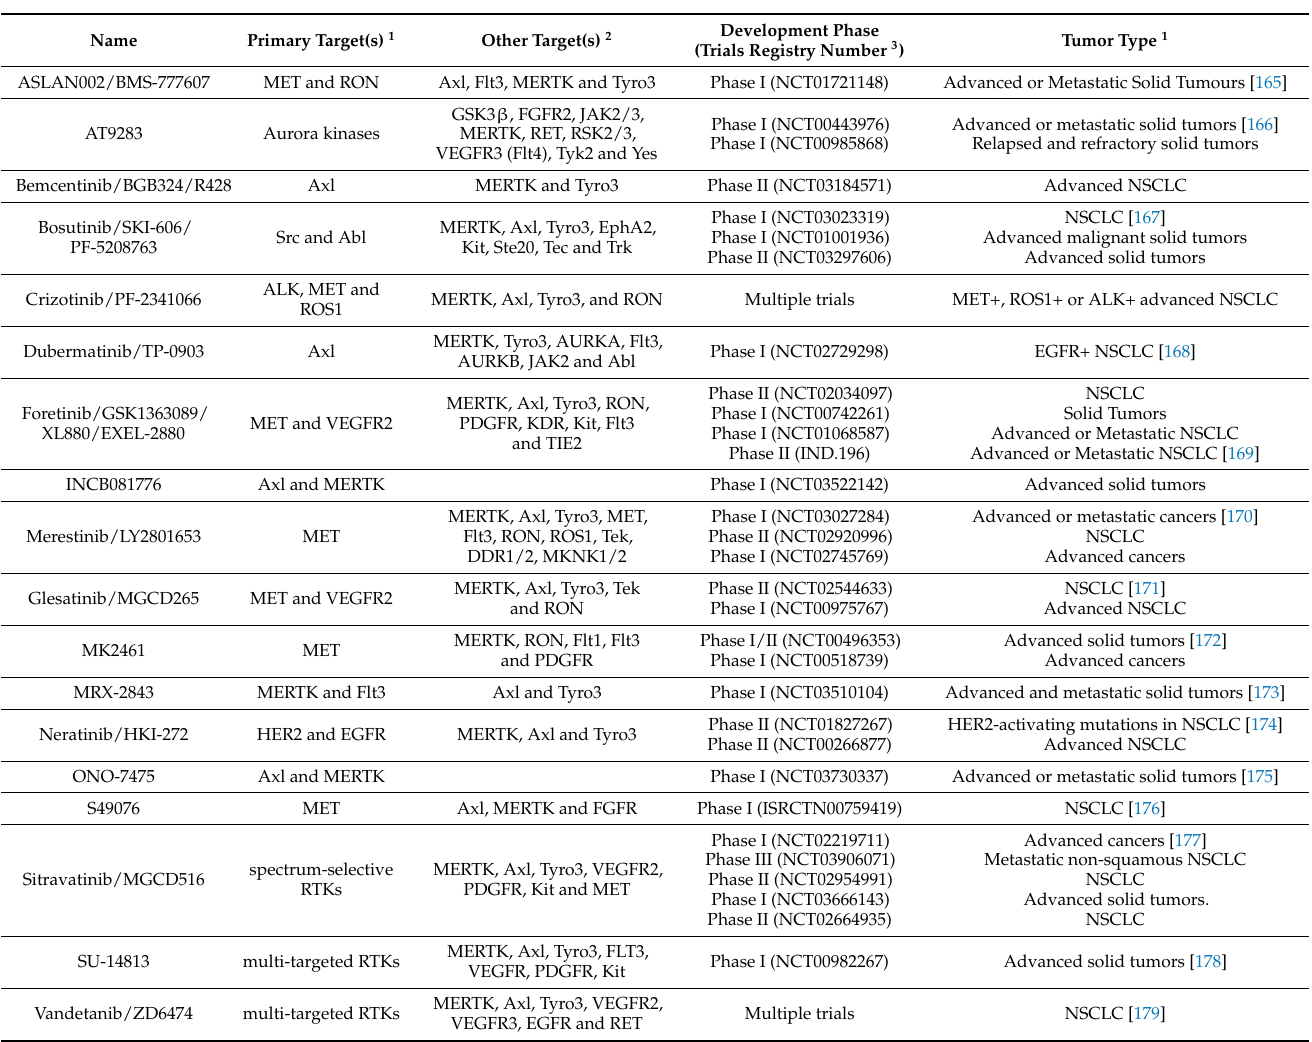
Table 2. The compounds harboring inhibitory activity of MERTK in clinical trials for NSCLC. 1 The inhibitory effect of individual compounds to corresponding primary targets has been approved by experimental data from biochemical, cell lines and animal studies. 2 The binding activities of compounds to their targets are screened by biochemical kinase selectivity assays. The inhibitory activities and cytotoxicity of some compounds are examined in cell lines. 3 Sources of information on clinical trials include ClinicalTrials.Gov (https://clinicaltrials.gov/ (accessed on 31 January 2021)), Canadian Cancer Trials Group Investigational New Drug (IND), International Standard Randomised Controlled Trial Number Register (ISRCTN) (https://www.isrctn.com/ (accessed on 31 January 2021)), and TrialTrove (https://citeline.com/ (accessed on 31 January